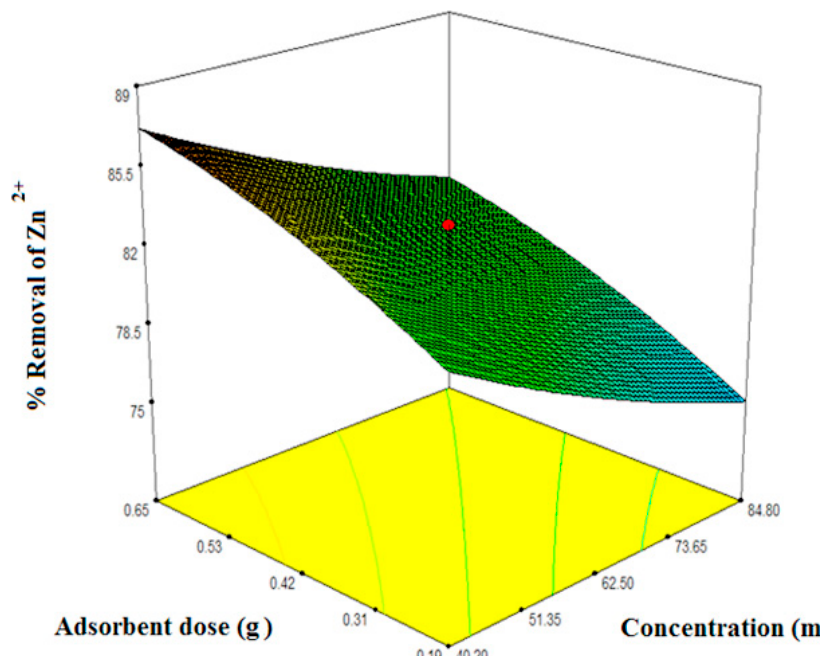
Water 2019 , 11 , x FOR PEER REVIEW Figure 5. Interacting effects of metal ions concentration and adsorbent dose at temperature 308 K.